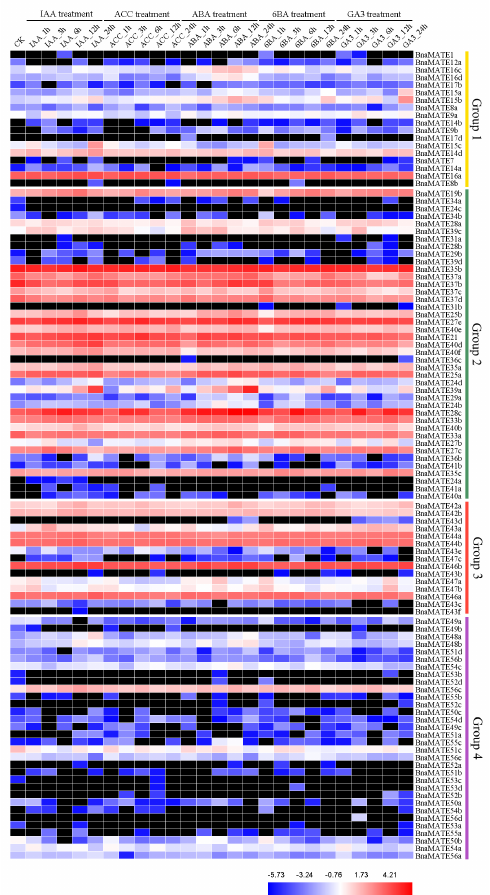
Figure 7. Expression analysis of BnaMATE family genes under hormone treatments. The color bar represents log 2 expression levels (FPKM). Red, blue, and white indicate high, low, and medium expression levels, respectively, and black indicates no expression (FPKM = 0). 18 BnaMATE genes are not shown because their expression was not detected in any condition. The abbreviations above the heatmap indicate the di ff erent hormones used to treat rapeseed plants (listed in Table